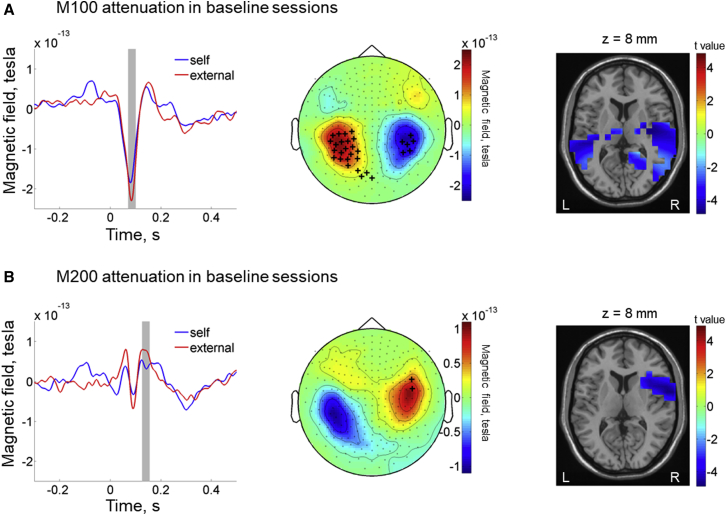
Replication of Sensory Attenuation in Baseline Sessions(A) Average evoked responses (left panel) are plotted from all the right hemisphere sensors (middle panel) where significant M100 attenuation is found (sensors marked with a plus sign; p < 0.05 with paired t tests; no correction for multiple comparisons). Background color in the middle panel shows the M100 topography (70–100 ms; grand average of the external tone-evoked responses in the pre-real session). The results are illustrated with the data from the pre-sham session. Source localization results with combined data from both baseline sessions (pre-sham and pre-real) show that M100 attenuation in the baseline session is strongest in the bilateral auditory cortex (right panel). Z-coordinate score is referenced to the Montreal Neurological Institute (MNI) brain. L and R indicate left and right, respectively.(B) The results of M200 attenuation in pre-real session are shown (left and middle panels) similarly to M100 attenuation effect. Background color in the middle panel shows the M200 topography (125–155 ms; grand average of the external tone-evoked responses in the pre-real session). Source localization results from combined baseline session data (pre-sham and pre-real) show that the strongest M200 attenuation is in the inferior frontal cortex and insula (right panel).